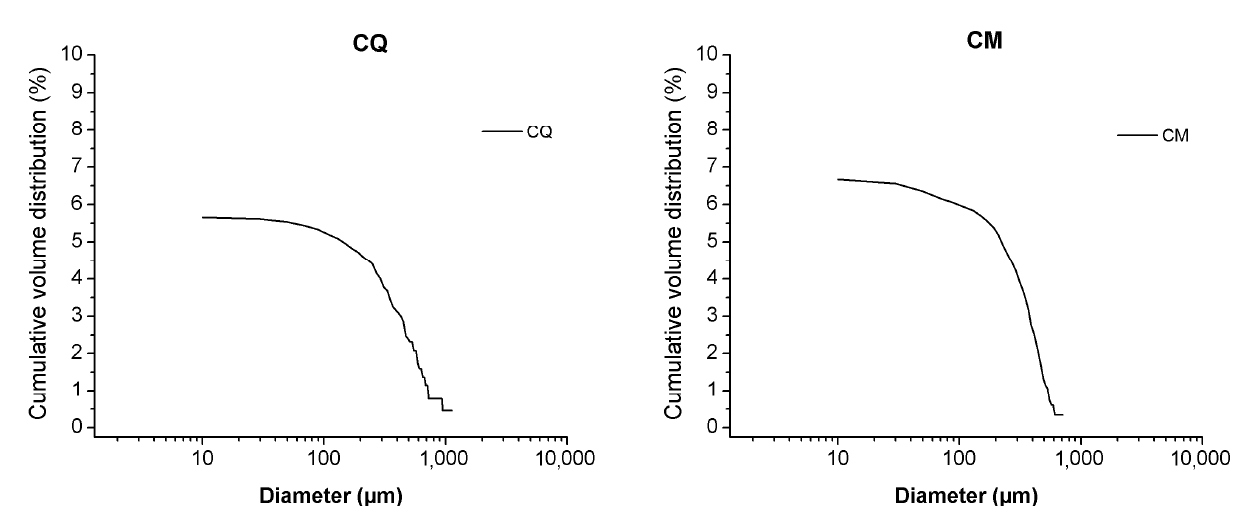
Figure 9. Cumulative porosity distribution of CQ ( left ) and CM ( right ) samples analyzed with computed X-ray tomography.